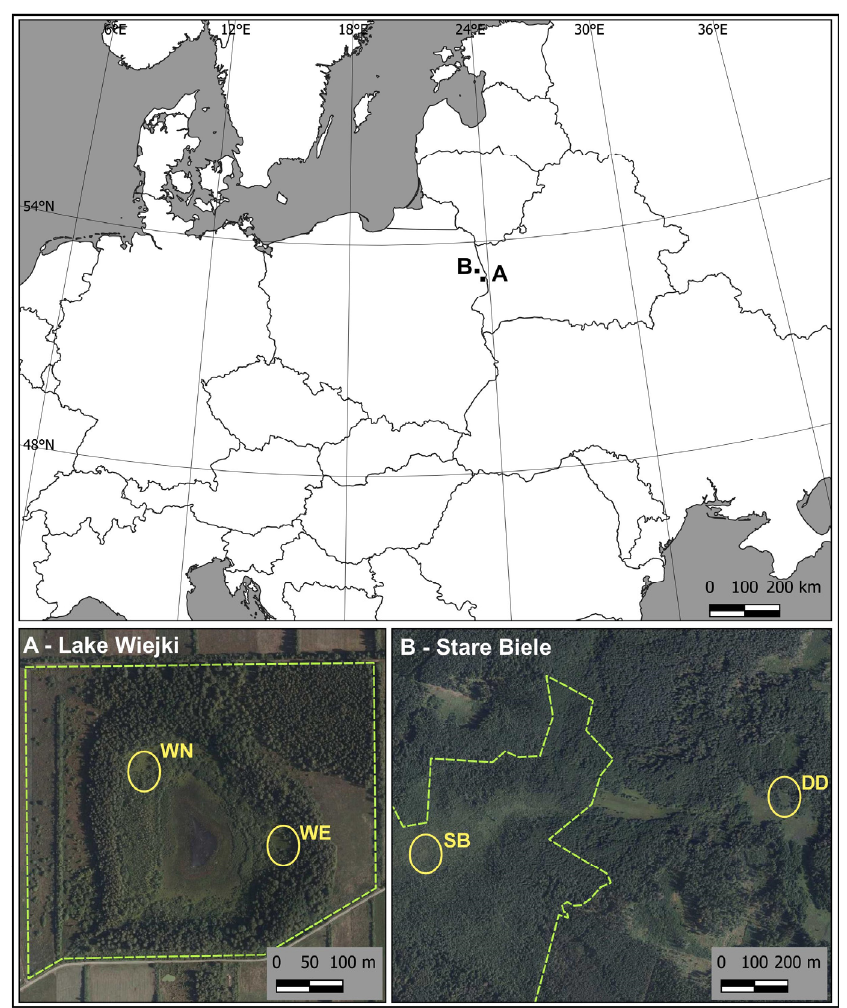
Figure 1. Map of the study area and location of reintroduction plots of downy willow. The yellow ellipses indicate an approximate location of reintroduction sites (WN, WE, SB, DD). The light green dashed line is the borderline of the nature reserves. The map was generated using the QGIS 3.16.4-Hannover software (Free and Open Source Software (FOSS); Free Software Foundation, Inc., Boston, MA, USA; www.qgis.org, accessed on 30 November 2022). Source for the orothophotomap: goeportal.gov.pl (Terms and conditions: https://www.geoportal.gov.pl/regulamin, accessed on 30 November 2022).